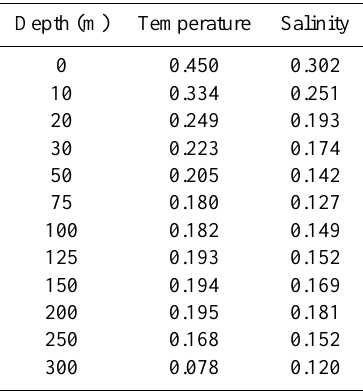
Table 4. Total explained variance at standard Levitus levels down to 300m for temperature and